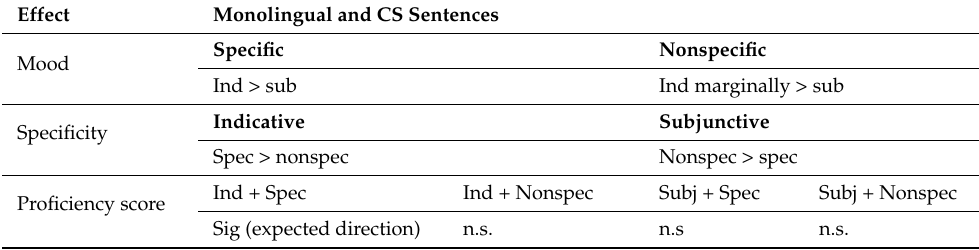
Table 4. Summary of results.